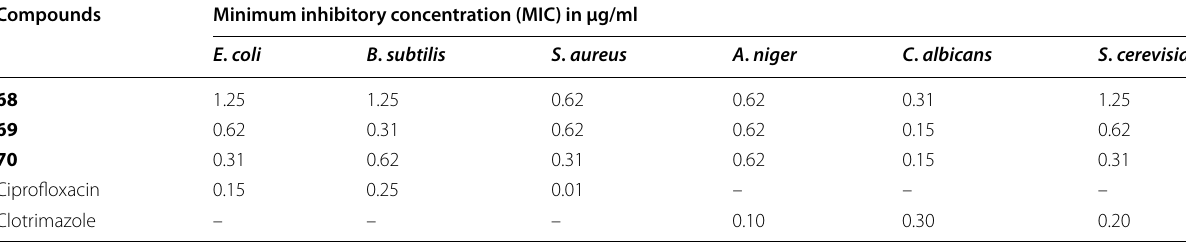
Table 20 Antimicrobial activities of synthesized compounds